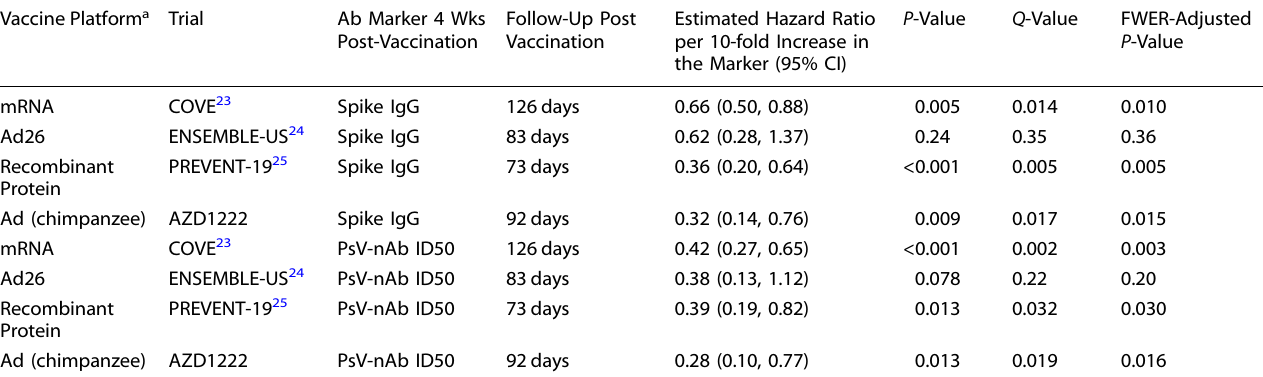
Table 3. Comparison of correlate of risk results for spike IgG and PsV-nAb ID50 across four randomized, placebo-controlled COVID-19 vaccine ef fi cacy trials (U.S. study